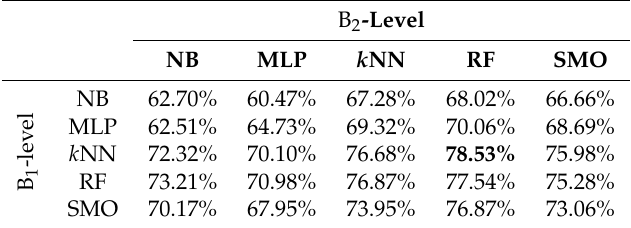
Table 6. Two-level classifier classification using RF as A-level classifier.